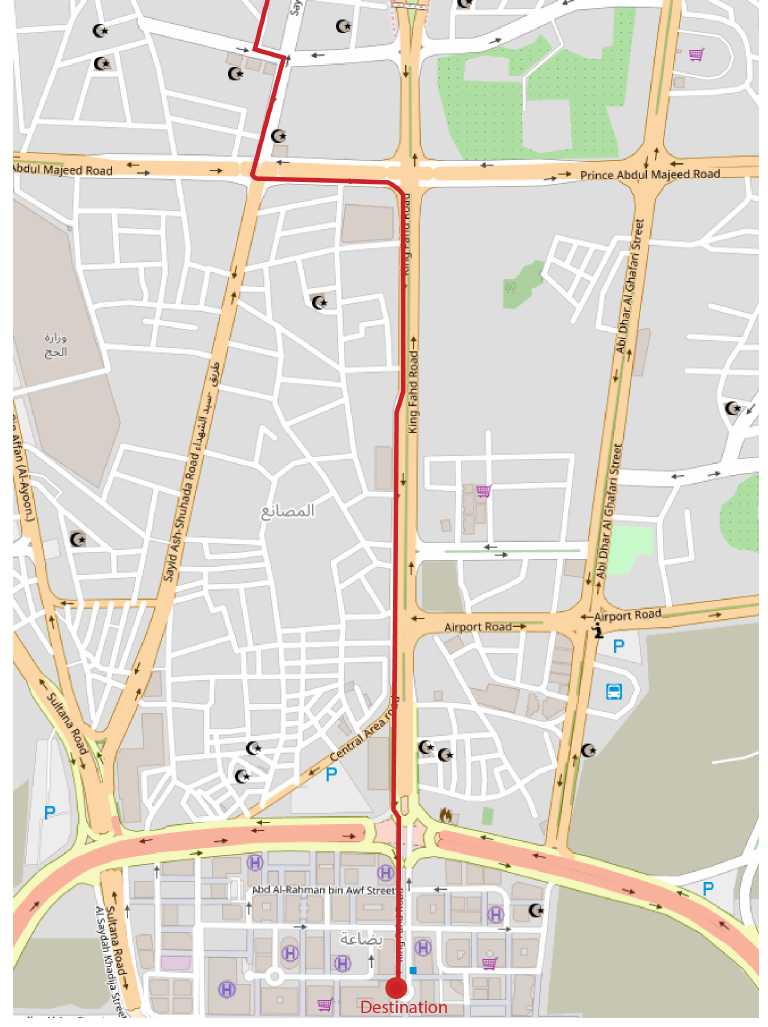
Figure 8. Route 3—North Highway to Prophet’s